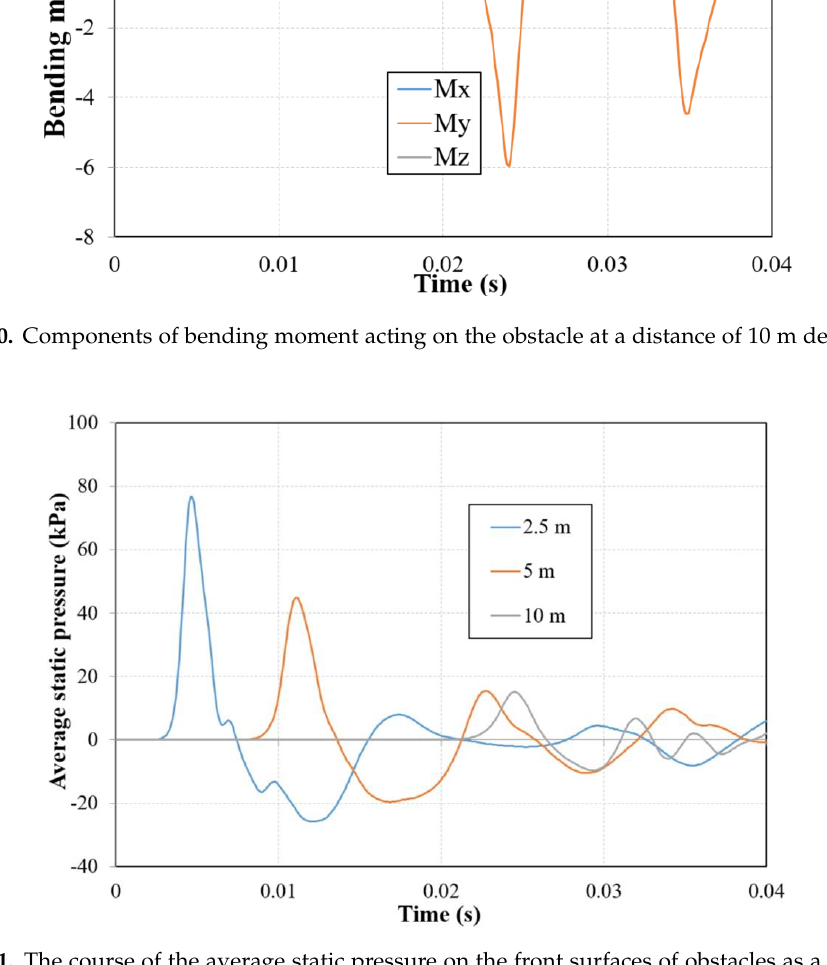
Figure 11. The course of the average static pressure on the front surfaces of obstacles as a function of time.